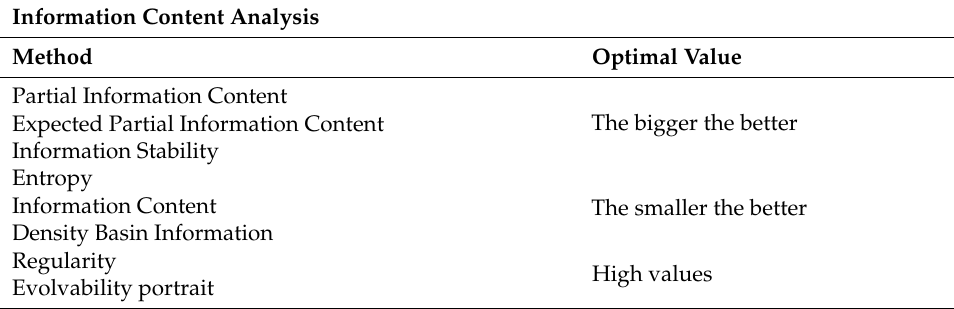
Table 5. Information content analysis evaluation